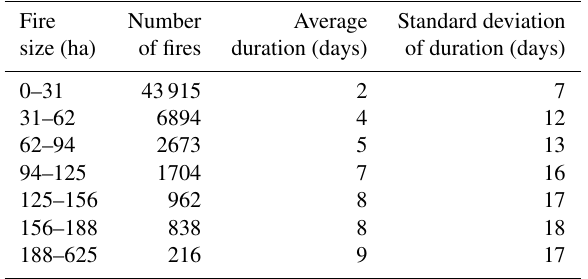
Figure A1. The burn-day distribution for the 12500–25000ha size class. Distributions for all six size classes are provided in the Sup- plement dataset (file \ Supplements \